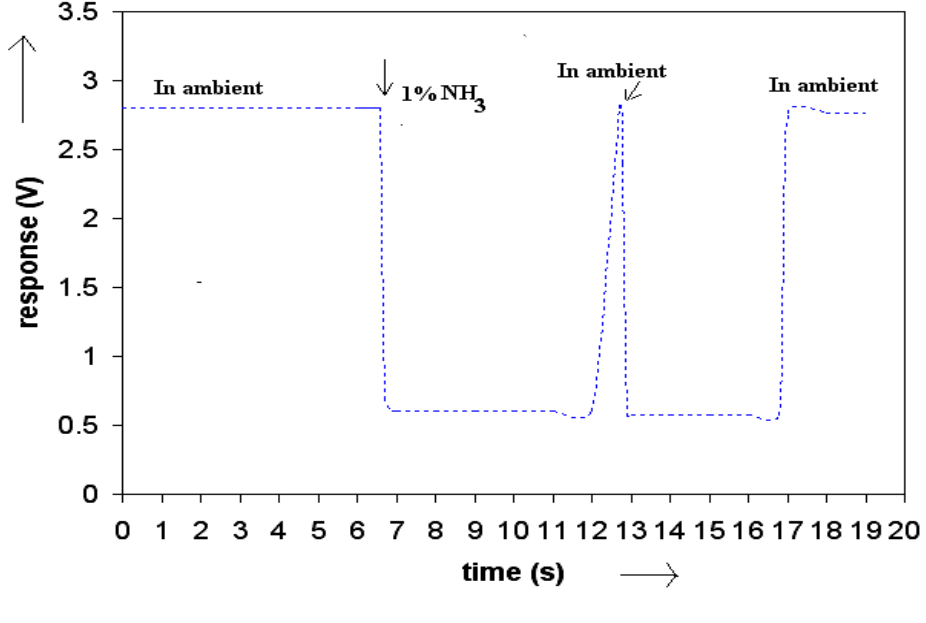
Figure 11 . Response-time curve for mixed conductor based TEMPOS